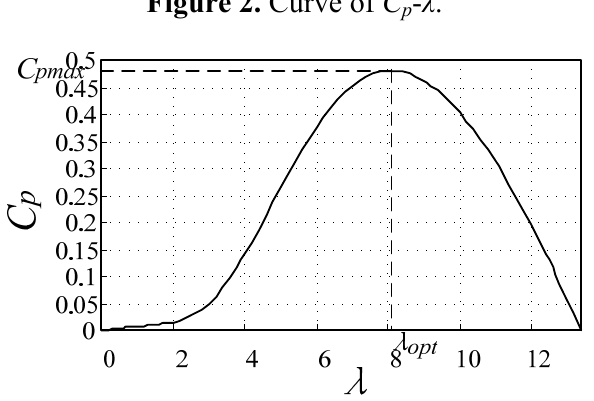
Figure 2. Curve of C